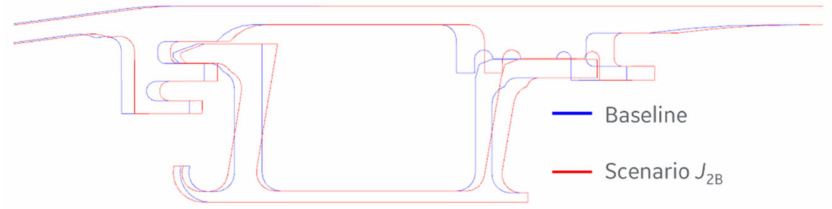
Figure 24. Geometry comparison between baseline and proposed configuration (scenario J 2B